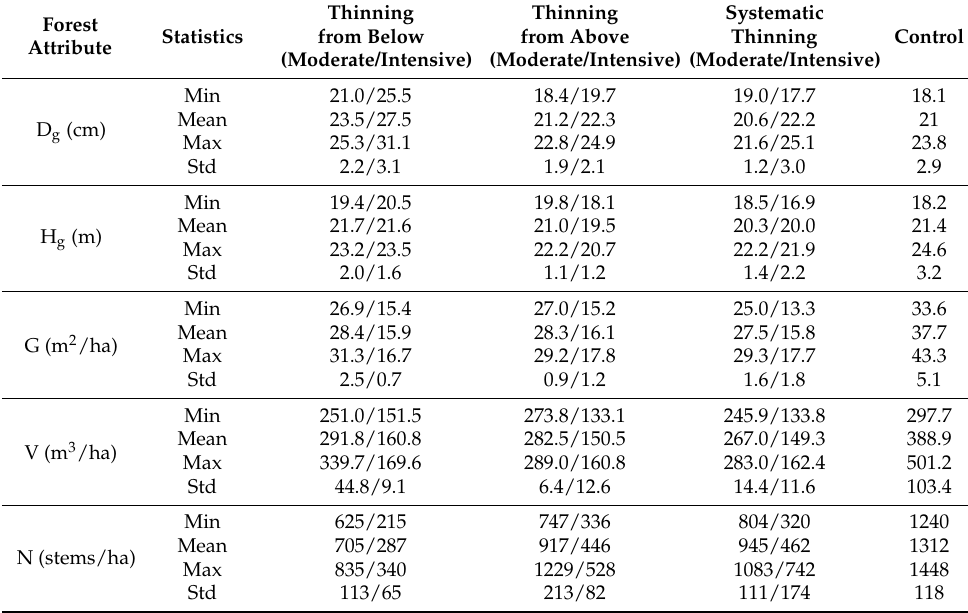
Table 1. Mean forest characteristics of each different thinning treatment and control sample plots at the latest field measurements, i.e., October 2018 for Pollari and April 2019 for Palomäki and Vesijako. D g = basal area-weighted mean diameter (cm), H g = basal area-weighted mean height (m), G = mean basal area (m 2 /ha), V = mean volume (m 3 /ha) and N = stems per hectare (n/ha). Moderate refers to thinning guidelines applied in Finland [43] whereas intensive resulted in 50% lower remaining basal area (m 2 /ha) compared to moderate thinning. Control refers to plots without thinning treatments since the establishment. Thinning Thinning Systematic Forest from Below from Above Thinning Statistics Attribute (Moderate/Intensive) (Moderate/Intensive) (Moderate/Intensive)